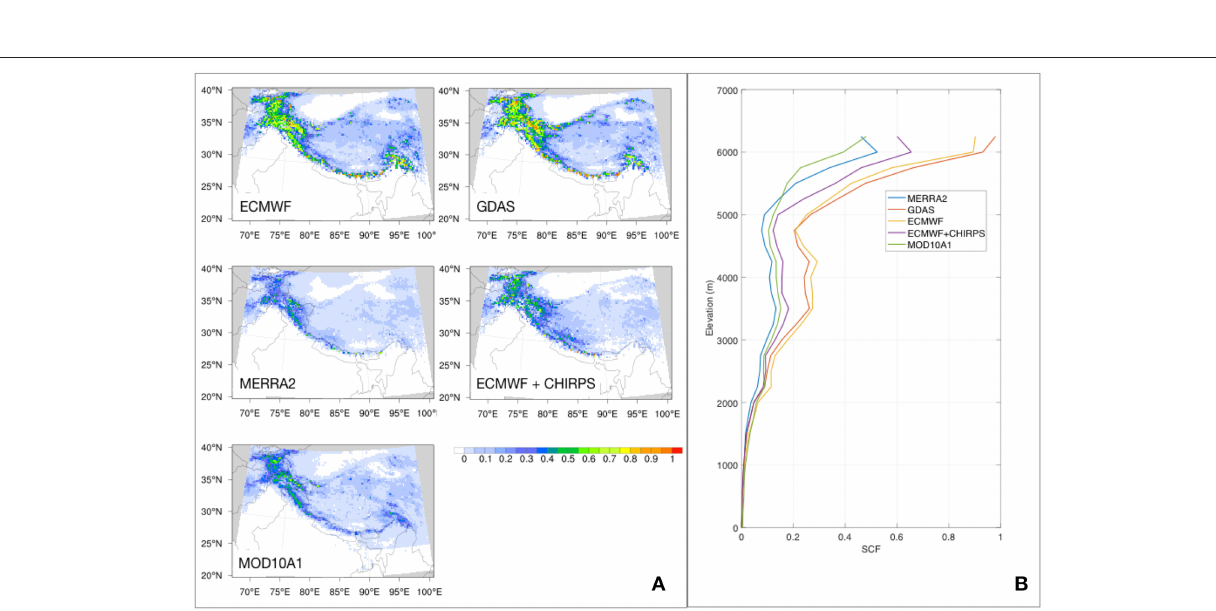
Frontiers in Earth Science |